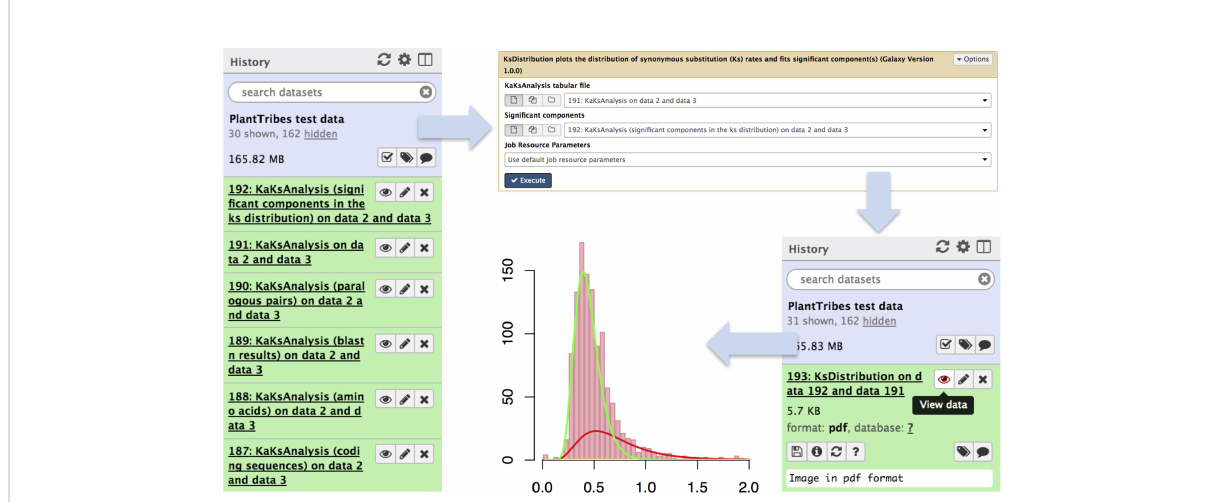
FIGURE 4 An illustration of genome duplication events detected using the Galaxy PlantTribes2 KaKsAnalysis tool. The KaKs analysis tool produces a list of outputs including self blastn results (item 189), a list of paralogous pairs (item 190), Ka (non-synonymous) and Ks (synonymous) substitution rates (item 191), and the signi fi cant components in the Ks distribution (item 192). Then the distribution of estimated paralogous pair Ks values is clustered into components using a mixture of multivariate normal distributions to identify signi fi cant duplication event(s) (item 193) and is visualized using Galaxy built-in